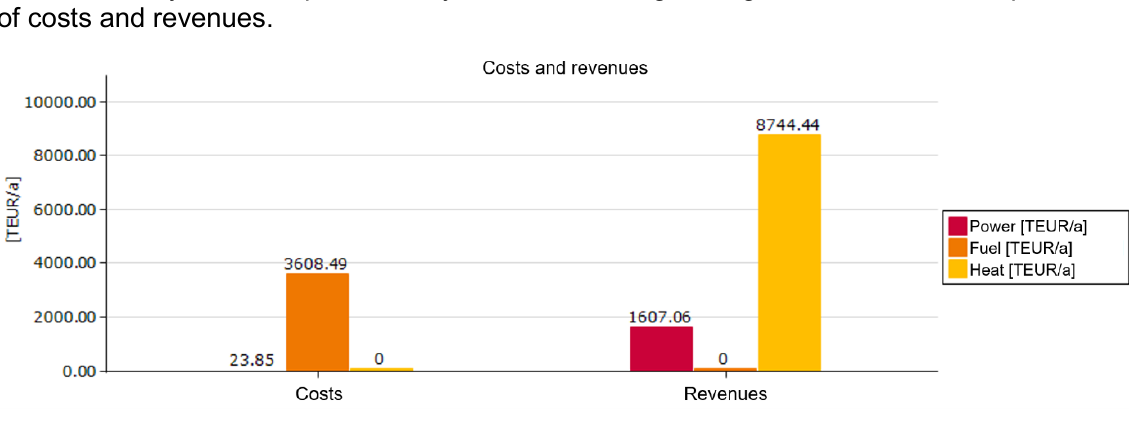
Figure 8. Comparison of costs and revenues per technology